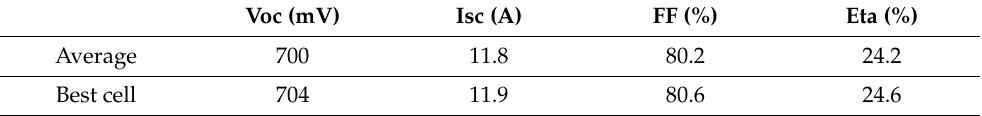
Table 2. Average IV data and best cell performance for a week of production in April 2022.